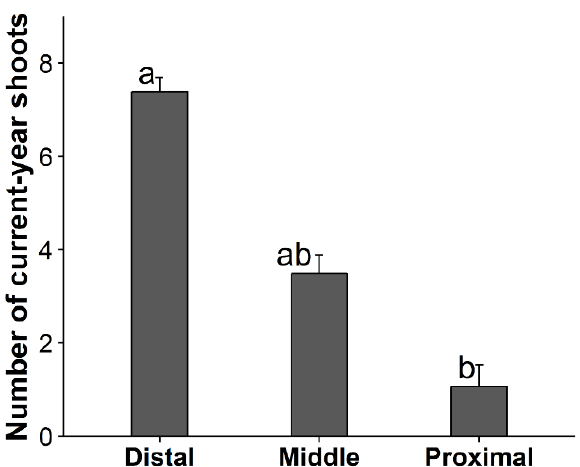
Figure 3. Differences in the mean number of current ‐ year shoots per secondary branch among the secondary branch positions. Different letters indicate significant differences between groups ( p < 0.05; Tukey honest significant difference test). The generalized linear mixed models coefficients are given in Table 3. Error bars indicate standard error.